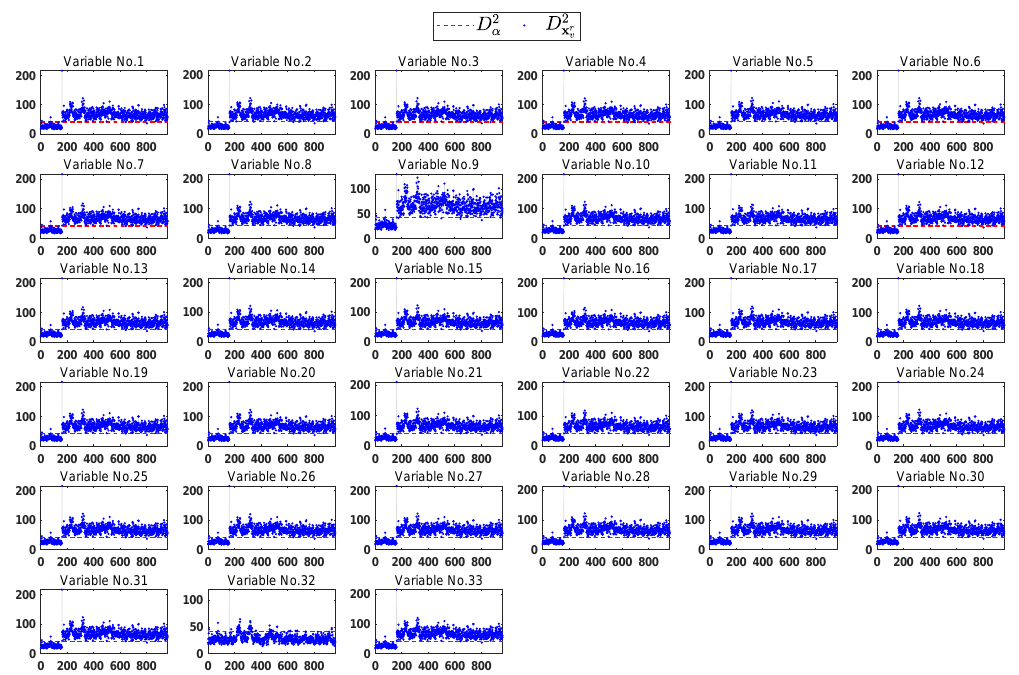
Figure 13. The fault detection results of reconstructed samples by estimating and replacing each variable for fault 4 of TE.